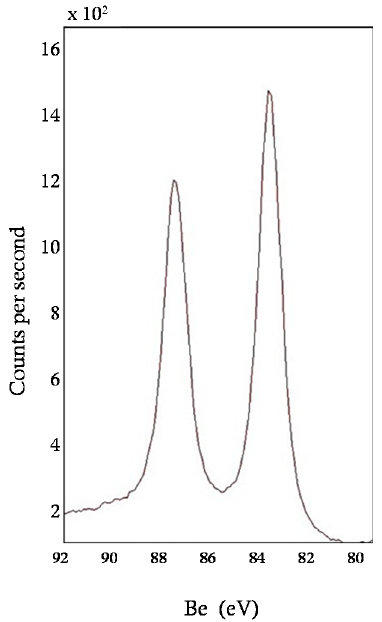
Figure 4. X-ray photoelectron spectroscopy (XPS) spectrogram of CF-Au. Au 4f with peaks corresponding to Au(0).